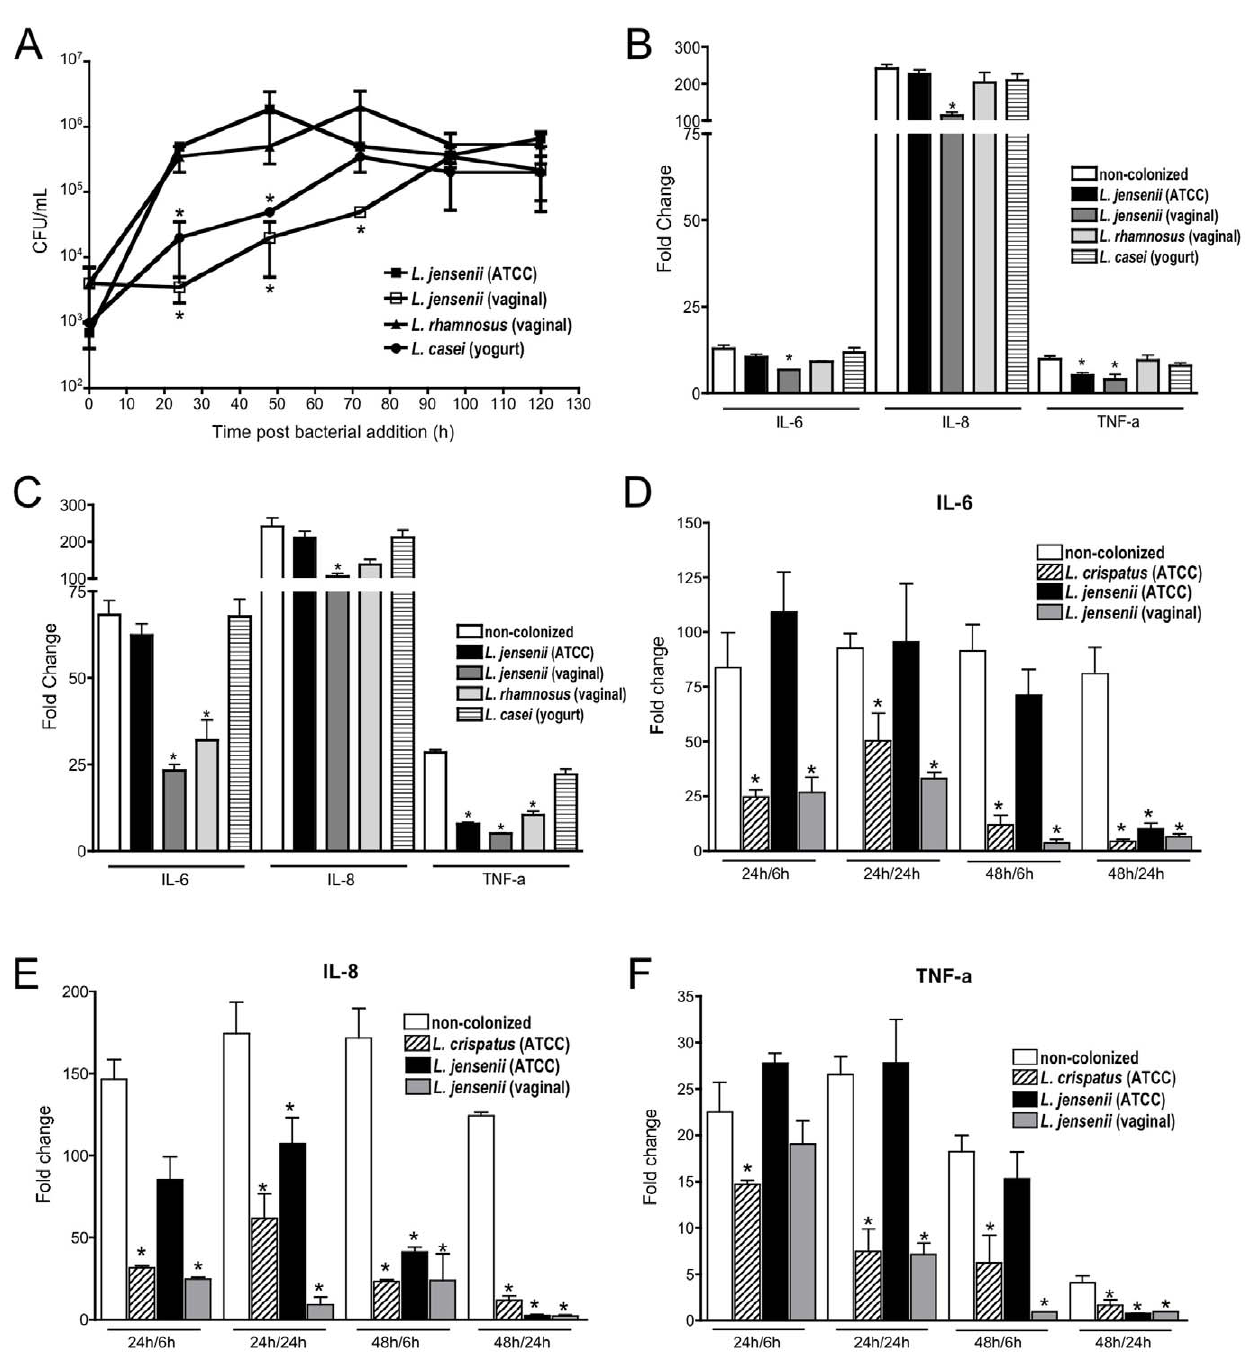
Figure 4. Commensal bacteria colonization from low pass clinical isolates and lab adapted strains showed distinct alterations in TLR agonist-induced cytokine expression. A . Colonization kinetics for several vaginal and non-vaginal Lactobacilli are presented over 5 d with statistically delayed growth for several of the isolates relative to the L. jensenii ATCC type strain (*p , 0.05, ANOVA) providing the opportunity to evaluate the impact of bacterial density on cytokine induction. B and C. Data from the standard paradigm indicated that after 24 h of bacterial colonization and 6 h of TLR agonist exposure (FSL-1 or PIC, panels B and C, respectively) showed even reduced titers of the indicated Lactobacilli strains could significantly reduce cytokine induction relative to non-colonized controls treated in parallel (*p , 0.05, ANOVA). Colonization with the clinical L. jensenii (vaginal) isolate that reached 24 h titers , 100-fold lower than the lab adapted isolate (ATCC) produced the most robust reduction in cytokine expression with more pronounced effects following PIC exposure (panel C). D–F. Given the different kinetics of colonization observed for each isolate we also kinetically tested selected bacteria for impact on PIC cytokine induction following either 24 or 48 h of colonization. TLR agonist exposures also were evaluated at two time points (6 and 24 h) creating four testing conditions both confirming and extending the previous observations. The data are presented as fold change relative to non-colonized cultures treated with PIC in parallel for IL-6 ( D ), IL-8 ( E ) and TNFa ( F ; * p , 0.05).